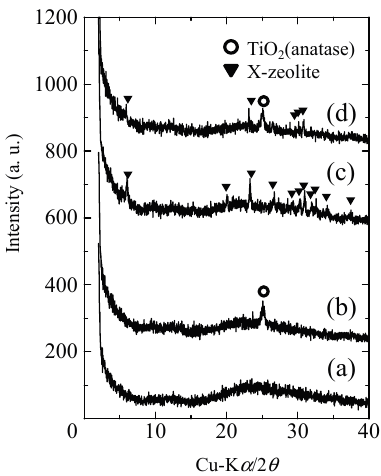
Figure 1. XRD patterns of the prepared samples: (a) partially sintered glass; (b) TiO 2 -coated partially sintered glass; (c) zeolite-porous glass composite; and (d) TiO 2 -coated zeolite-porous glass composite.